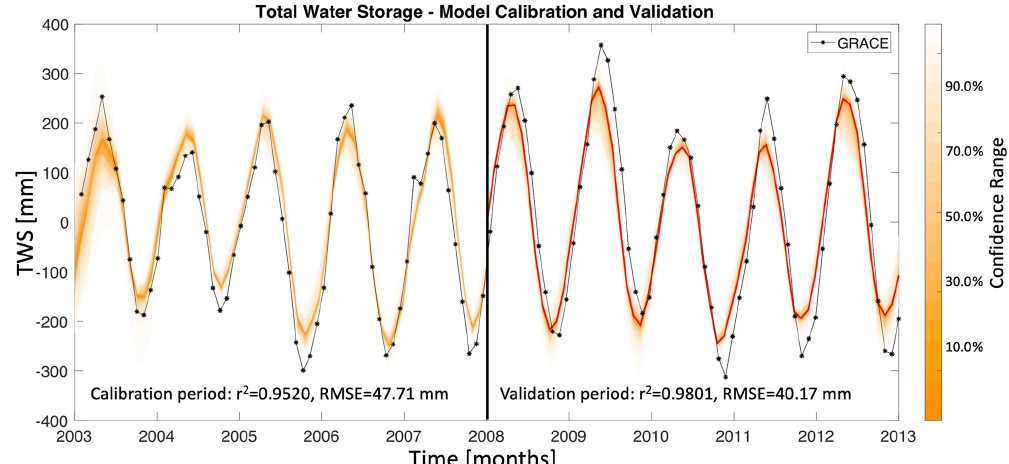
Figure 6. Model calibration and validation for monthly TWS anomaly estimates in the Gavião watershed, for the period January 2003 through December 2012. The plot shows the first 5 years of the data for calibration and the remaining 5 years for validation. GRACE- informed posterior ranges of the model-simulated TWS are shown here in the orange envelopes for the calibration and validation years, and the red line is used to represent the mean estimates for the validation